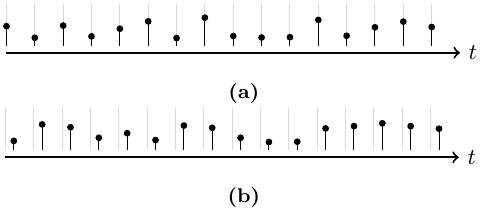
Figure 4: Two discrete signals that are sampled at different absolute points in